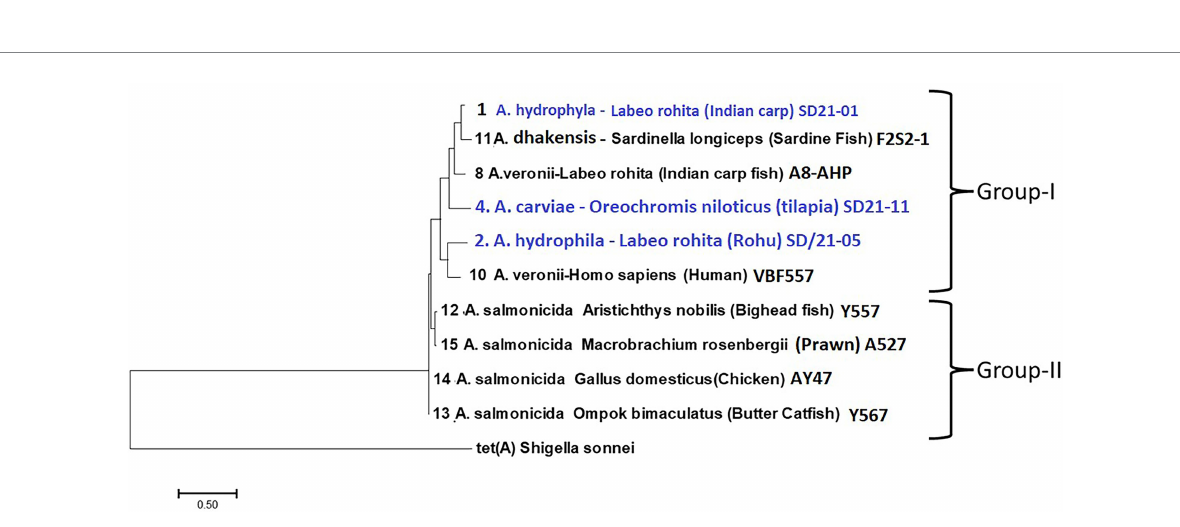
FIGURE 3 Phylogenetic analysis of Ambler class C β -lactam resistance genes from 10 Aeromonas spp. isolated from different host species in India. The isolates were put in two groups. (i) Group 1 consists of bla AQU-2 , cepS , bla MOX-7 , and bla FOX-7 genes from A. hydrophila , A. veronii , and A. caviae isolated from different host species. Note that Strains SD/21–01 and F2S2/1 having the bla AQU-2 gene were put together while strains SD/21–05 and VBF557 having the cepS gene were also placed together. (ii) Group 2 consists of bla FOX-2 , bla FOX-4 and bla FOX-5 genes from A. salmonicida isolates of which strains Y567 and Y527 having the bla FOX-2 gene were put